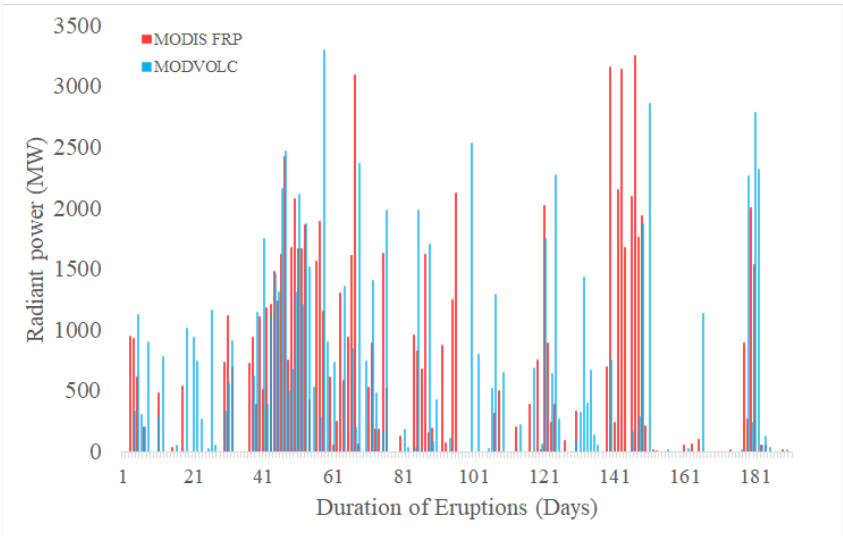
Table 1. Spearman correlation coefficient showing the degree of correlation between MODIS FRP and MODVOLC during the 2021 Fagradalsfjall eruption.